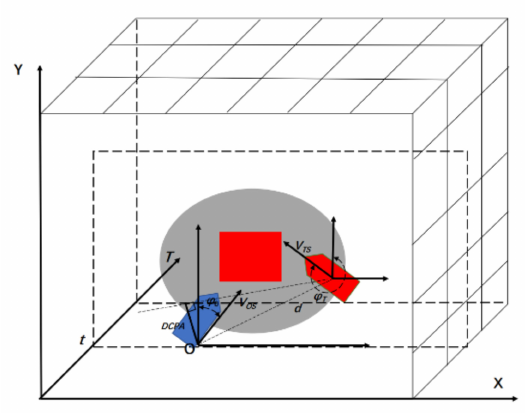
Figure 6. Space-time dynamic